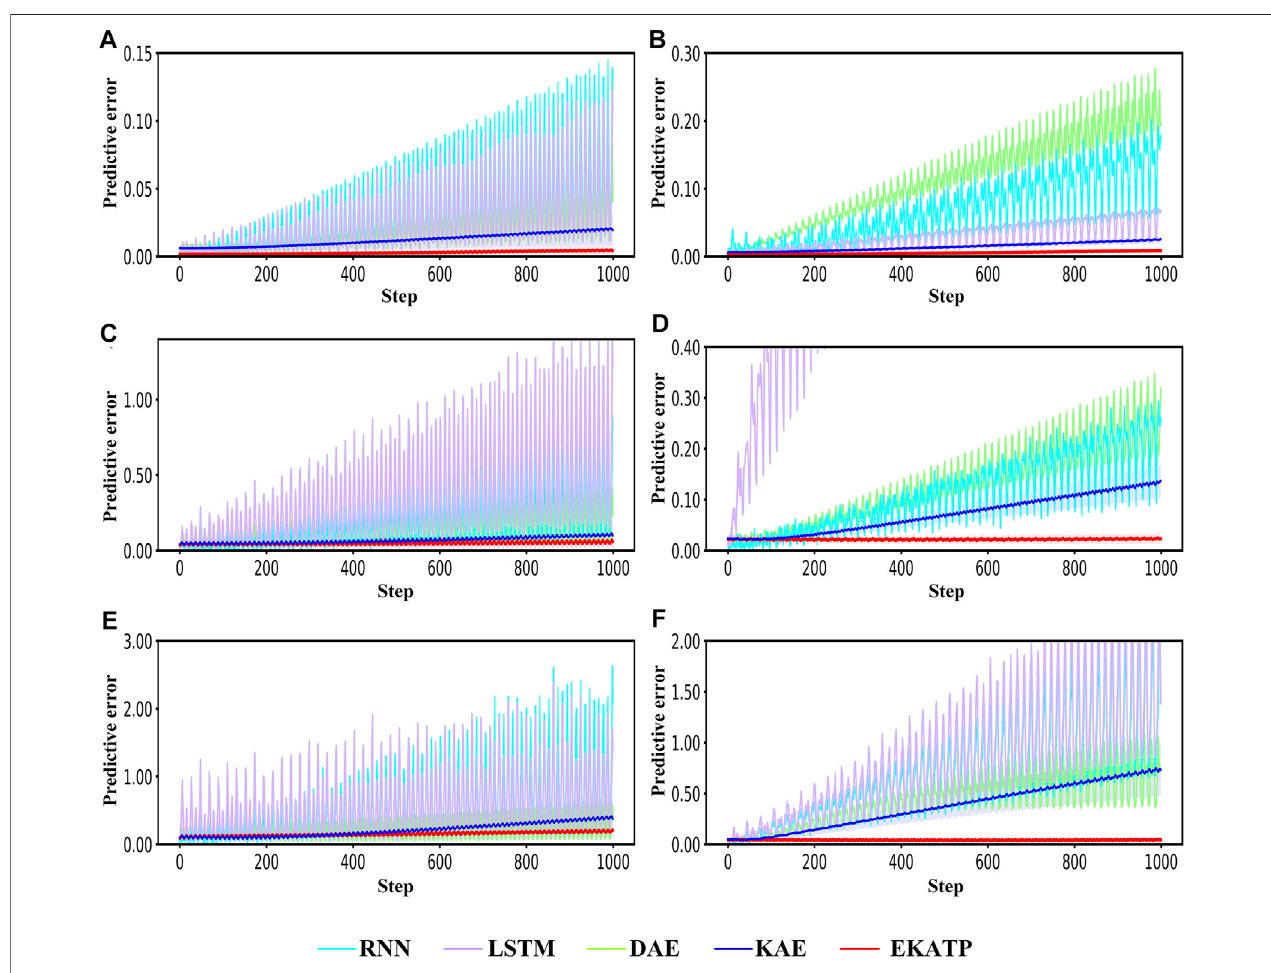
FIGURE 4 | Comparison with the RNN, LSTM, DAE, KAE and EKATP. The abscissa represents the step, and the ordinate represents the predictive error. (A) The initialconditionsare h (cid:1) 0.8and σ (cid:1) 0.00. (B) Theinitialconditionsare h (cid:1) 2.4and σ (cid:1) 0.00. (C) Theinitialconditionsare h (cid:1) 0.8and σ (cid:1) 0.03. (D) Theinitialconditionsare h (cid:1) 2.4 and σ (cid:1) 0.03. (E) The initial conditions are h (cid:1) 0.8 and σ (cid:1) 0.08. (F) The initial conditions are h (cid:1) 2.4 and σ (cid:1) 0.08.